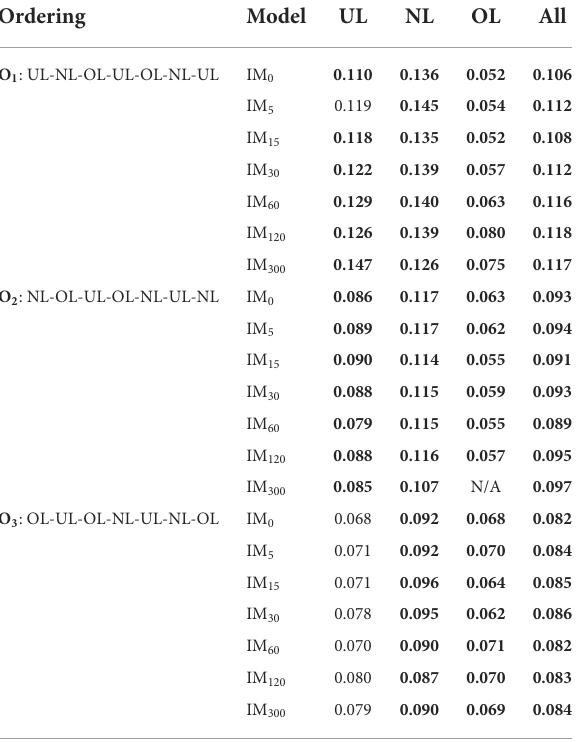
TABLE 3 The predicted performance MAE for each individualized model by workload condition and workload ordering. Ordering Model UL NL OL All